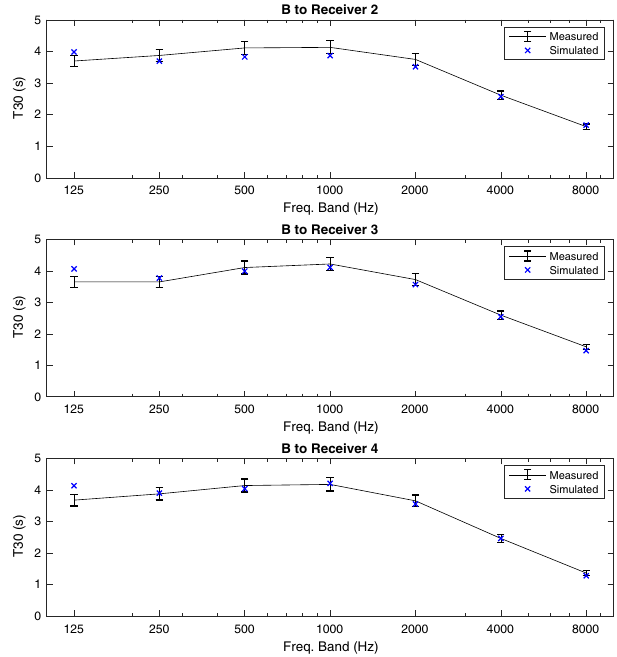
Figure 6. T30 simulations versus measurements from source position B (Error bars = ±1 JND).